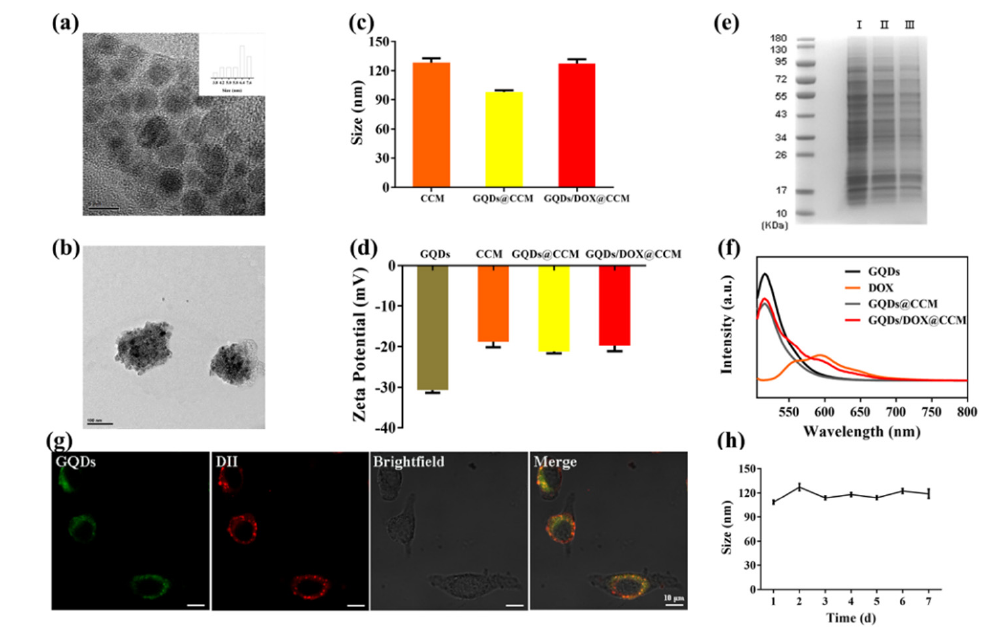
Figure 3. Characterization of GQDs/DOX@CCM. ( a ) TEM image of GQDs. Scale bar = 5 nm. ( b ) TEM image of GQDs/DOX@CCM. Scale bar = 100 nm. ( c ) DLS analysis of CCM, GQDs@CCM, and GQDs/DOX@CCM. ( d ) Zeta potentials of GQDs, CCM, GQDs@CCM, and GQDs/DOX@CCM. ( e ) SDS-PAGE protein analysis of I CCM, II GQDs@CCM, and III GQDs/DOX@CCM. ( f ) PL spectra of